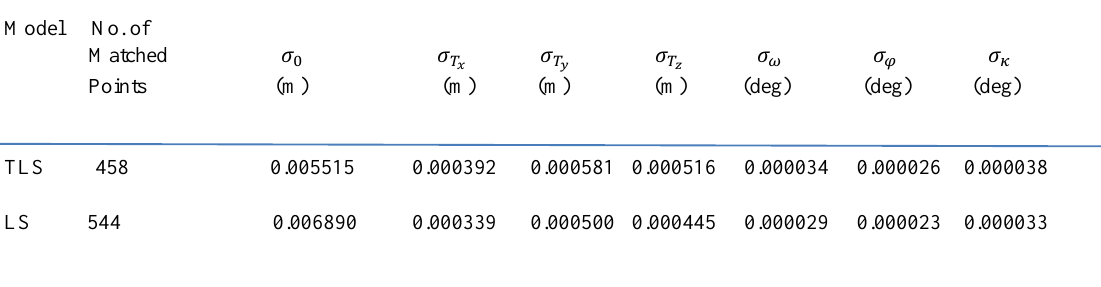
Table 2. Numerical results of ‘Historical Building’